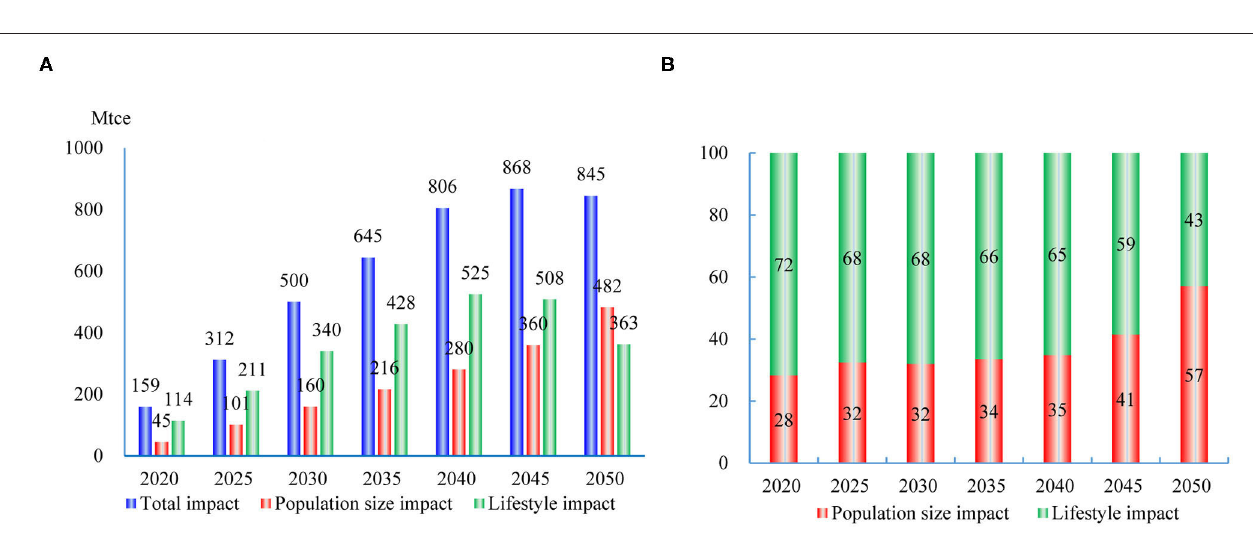
FIGURE 7 | The factor decomposition of the total energy consumption changes. (A) The decomposition of total energy consumption changes. (B) The contributions of different impact factors to energy consumption